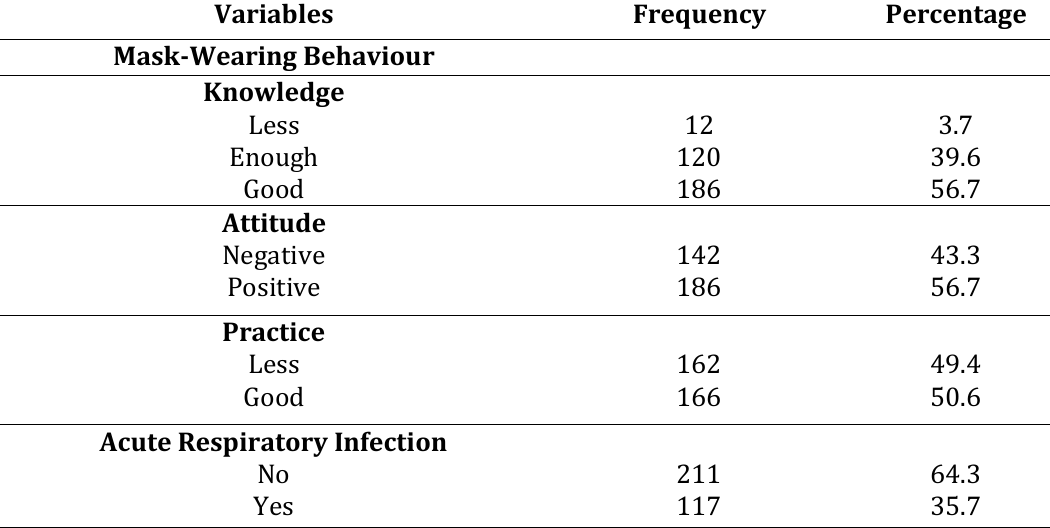
Frequency distribution of mask-wearing behaviour and incidence of acute respiratory tract infections during the COVID-19 Pandemic among students in Jakarta